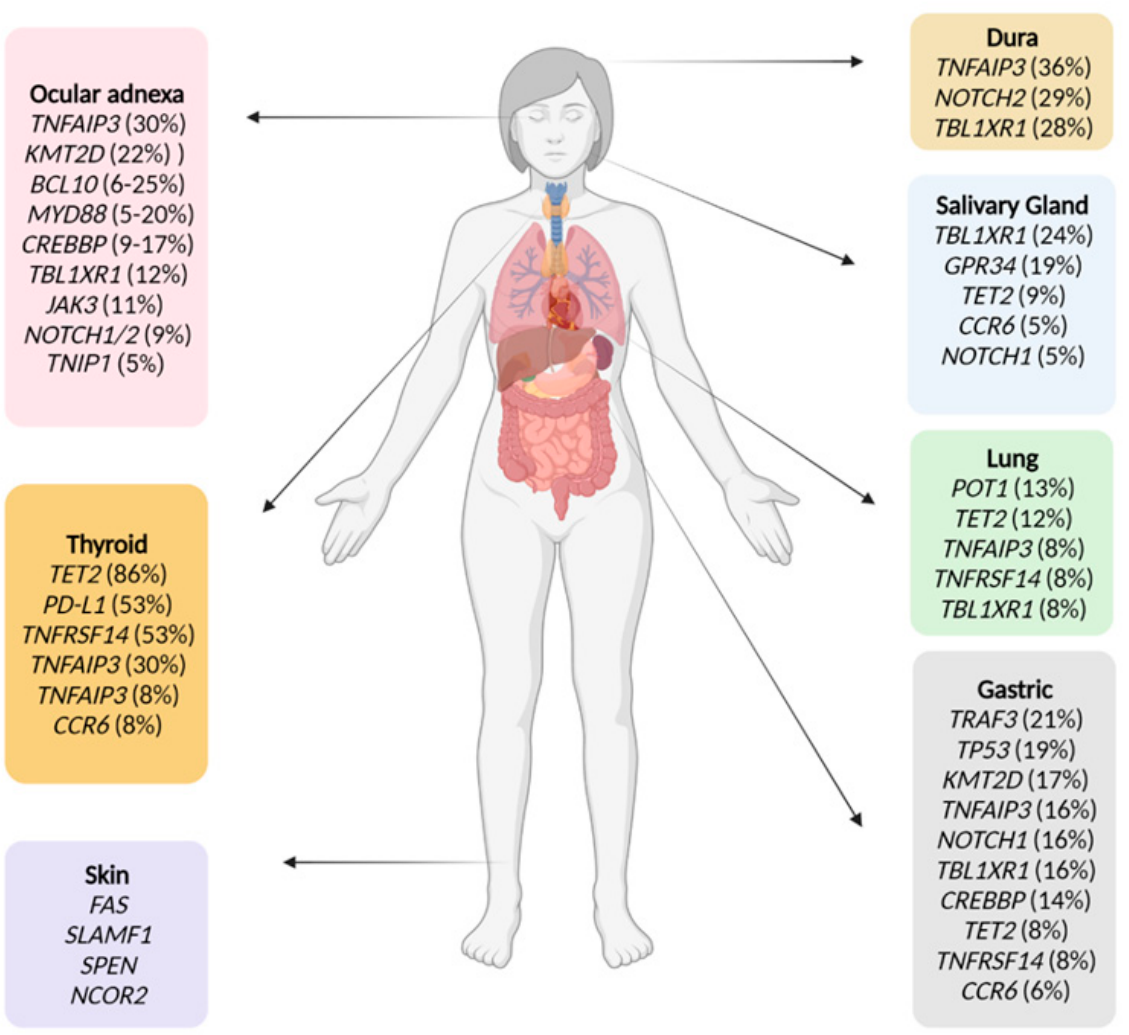
Figure 1. Recurrently mutated genes in MALT lymphoma according to site of origin. Created with BioRender.com.